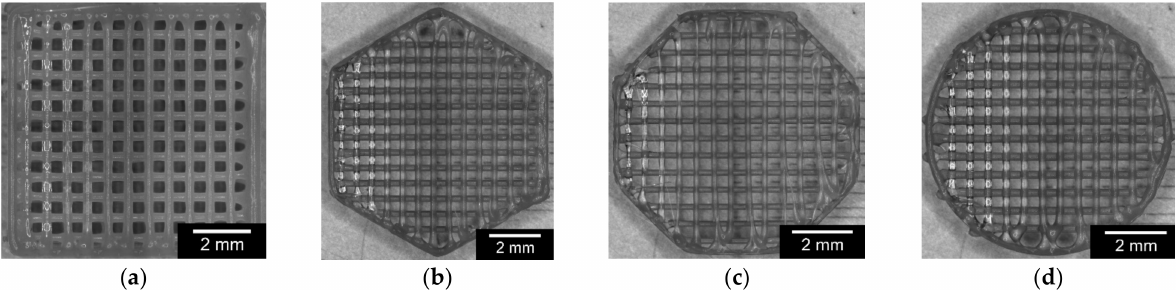
Figure 1. Comparison of PCL scaffolds with variations in outer geometry: ( a ): square; ( b ): hexagon; ( c ): octagon; ( d ):